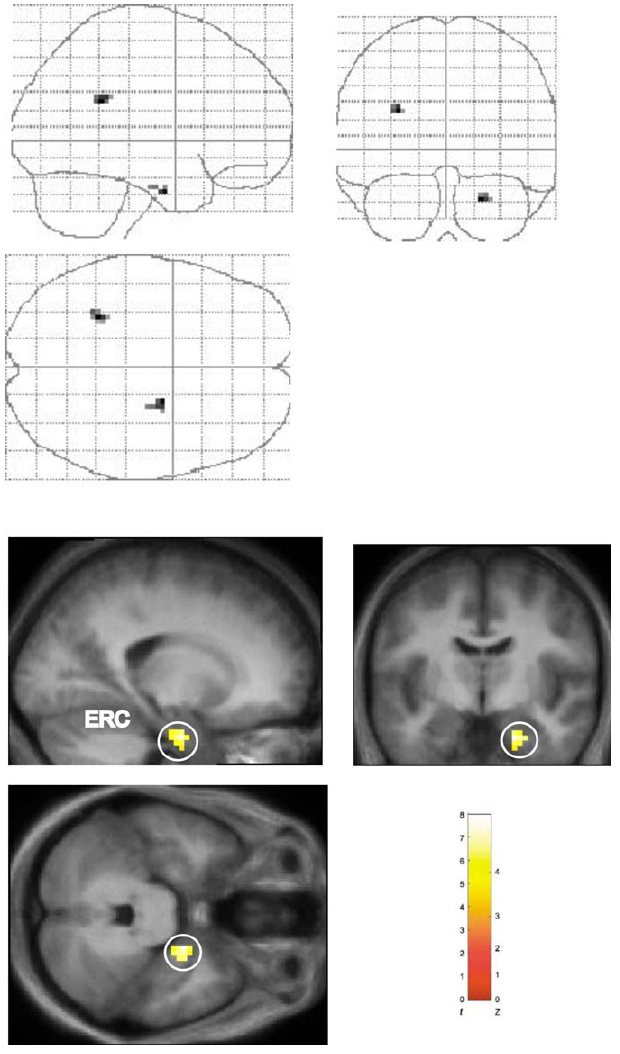
Figure 4. Main Effect of Sequence Type in Right Entorhinal/Perirhinal Cortex: S half þ S new . S rep Significantly greater activation observed in right entorhinal/perirhinal cortex (ERC) in comparison of S half and S new conditions against S rep condition (S half þ S new . S rep , collapsed across object-context factor). ‘‘ Glass brain ’’ figures are displayed above. Activations shown on the averaged structural MRI scan of the 17 participants (displayed below). The color bar indicates the t-statistic associated with each voxel, and the Z -score equivalent. Activation in right entorhinal/perirhinal cortex ( x, y, z ¼ 21, (cid:2) 6, (cid:2) 30; z ¼ 3.56) circled in sagittal, coronal, and axial planes. Threshold is set at p , 0.005 uncorrected for display purposes. DOI: